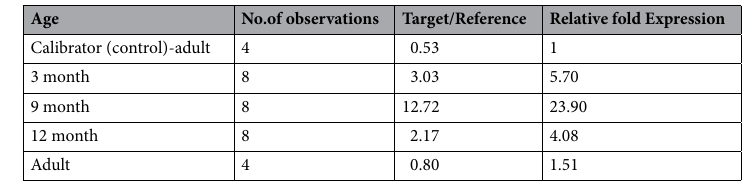
Table 4. Relative mRNA expression (fold change) of HSP70 gene in different age groups of Jamunapari goats. No. Number or sample size; 3, 9, 12 month and adult, Age of Jamunapari goats.